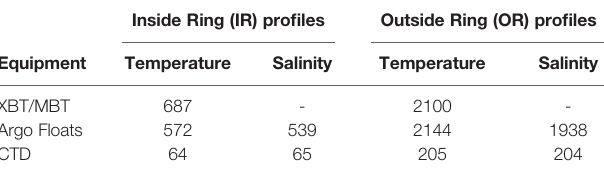
TABLE 1 | Number of temperature and salinity pro fi les from the EN4.2.0 dataset remaining after quality